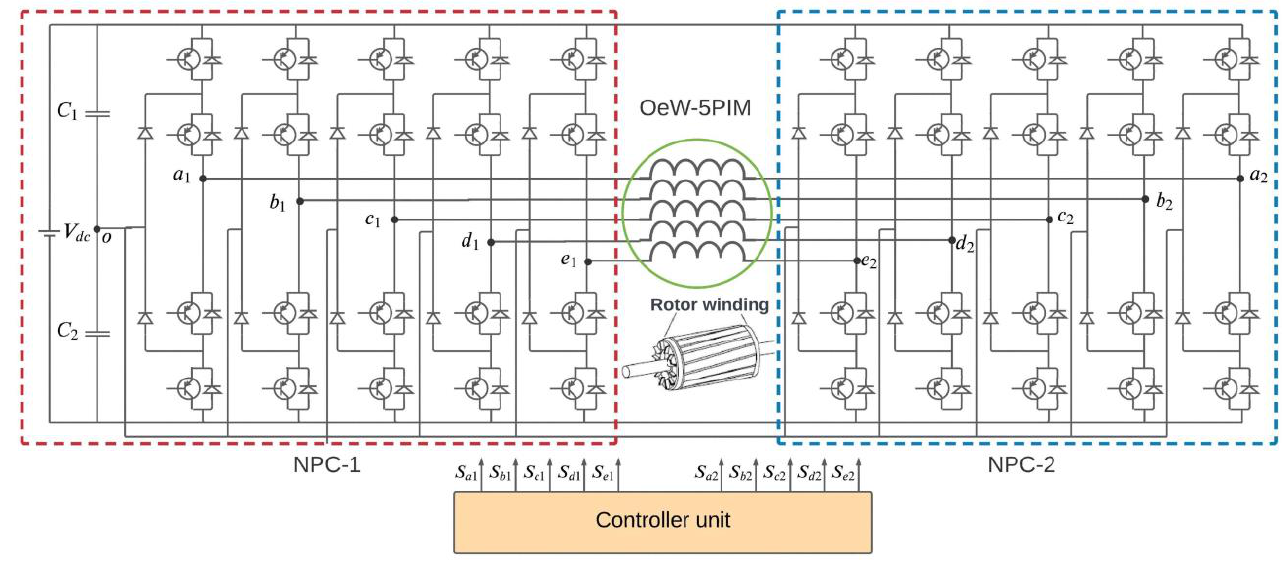
Figure 1. Power circuit of OeW-5PIM topology with a single DC source.